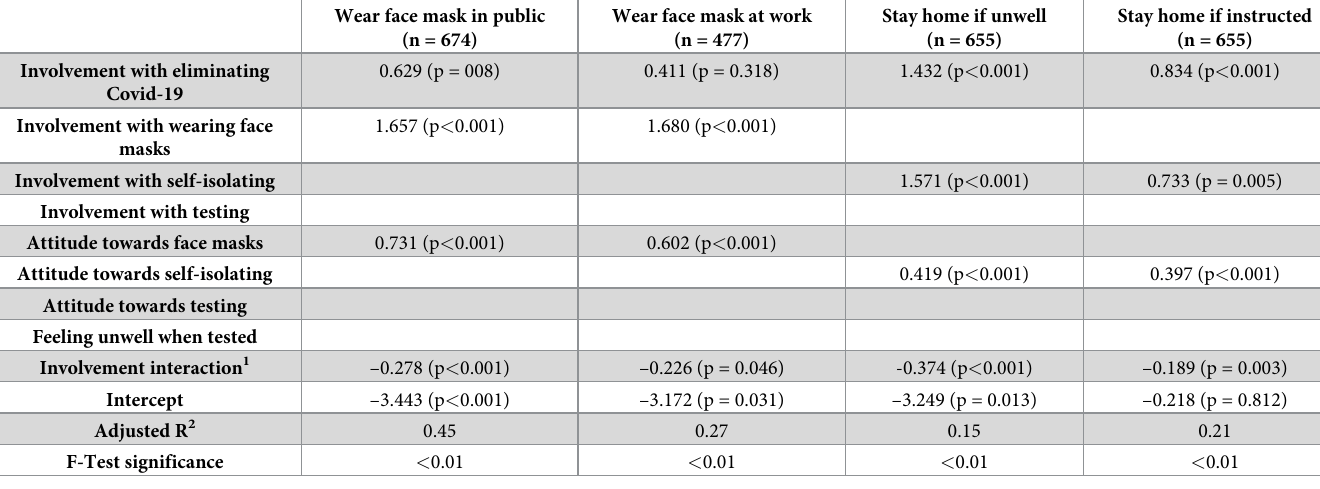
Table 10. Parameter estimates for propensity to wear face masks and self-isolate.